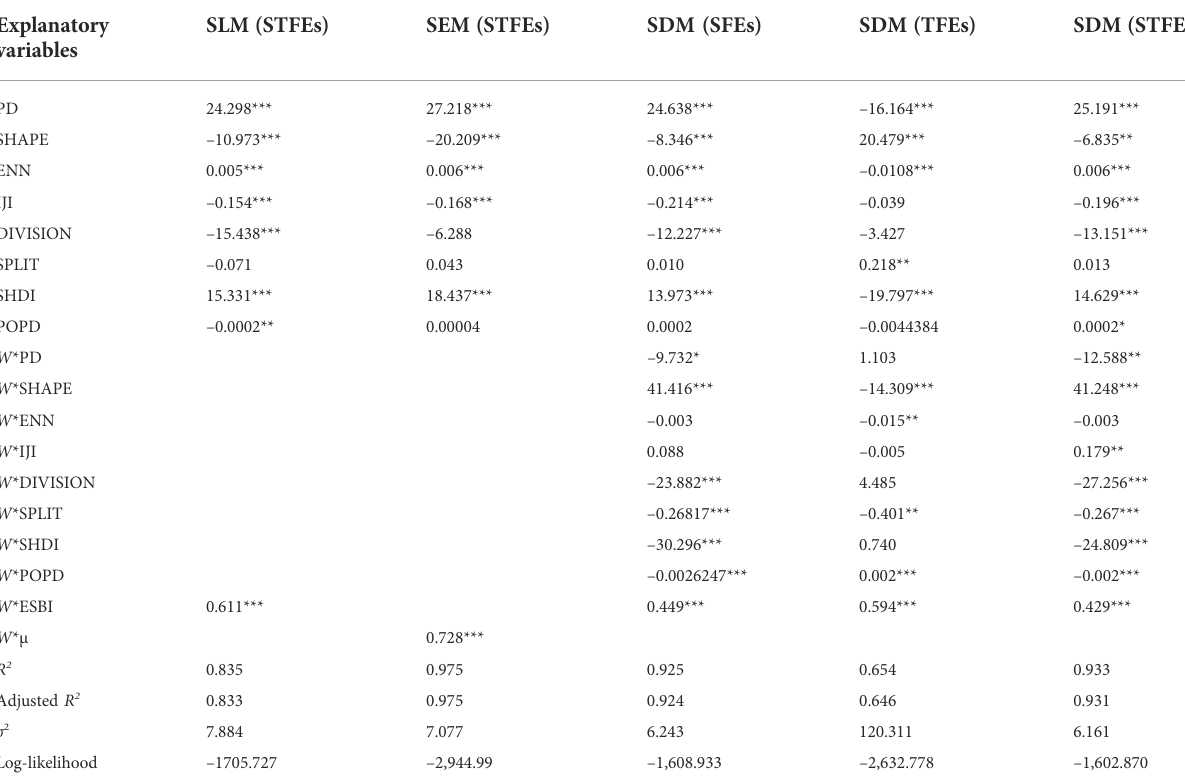
TABLE 2 Spatial associations between the ESBI and explanatory variables quanti fi ed using the SECMs.